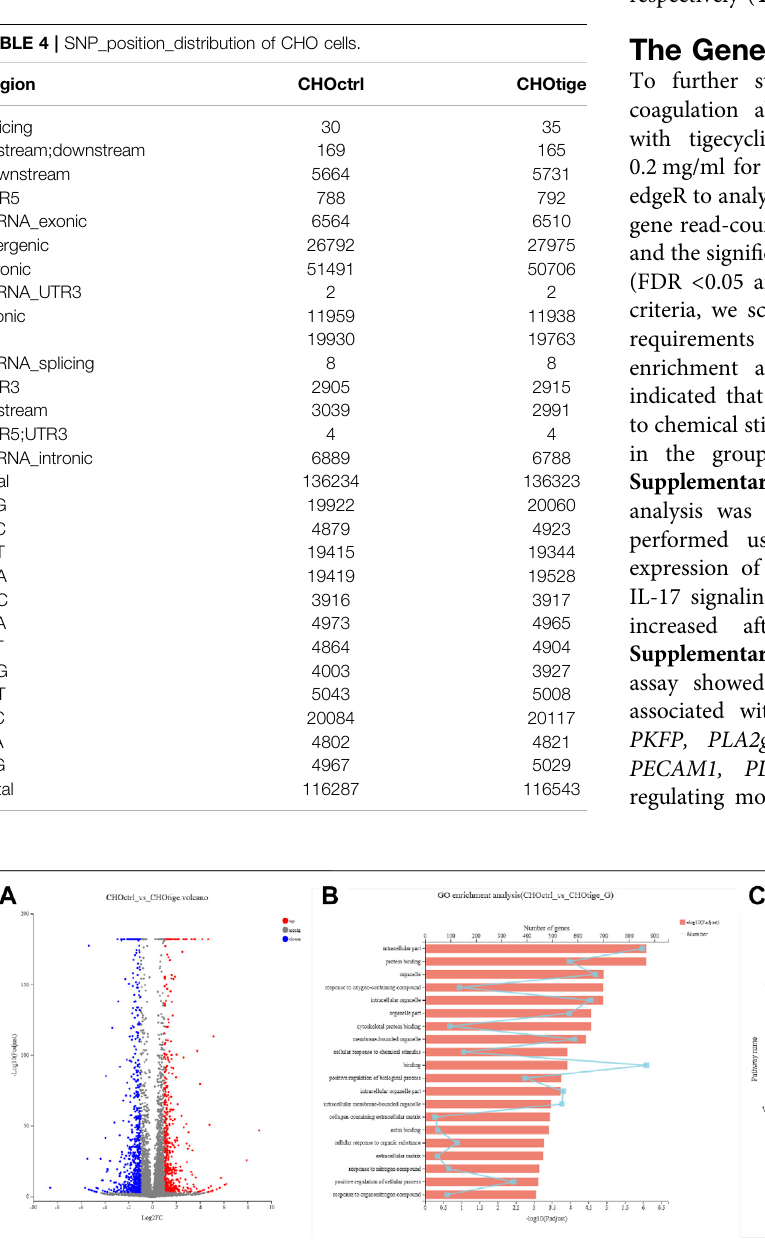
Frontiers in Pharmacology |